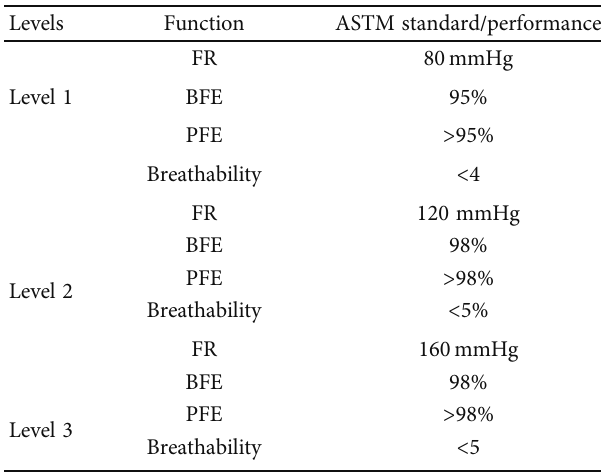
Table 3: Various protection levels of surgical masks according to